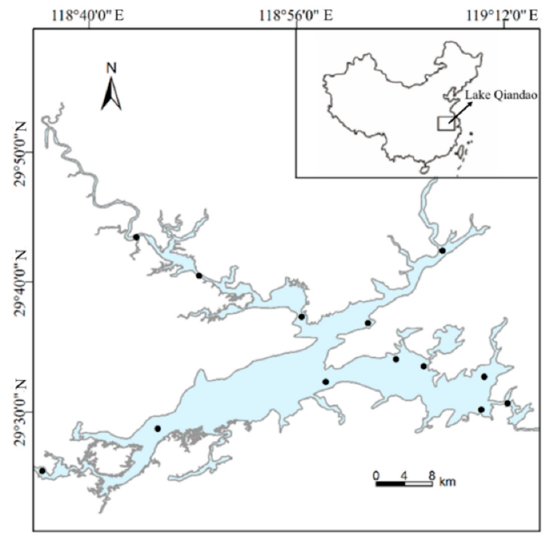
Figure 1. Map of Lake Qiandao in southern China.